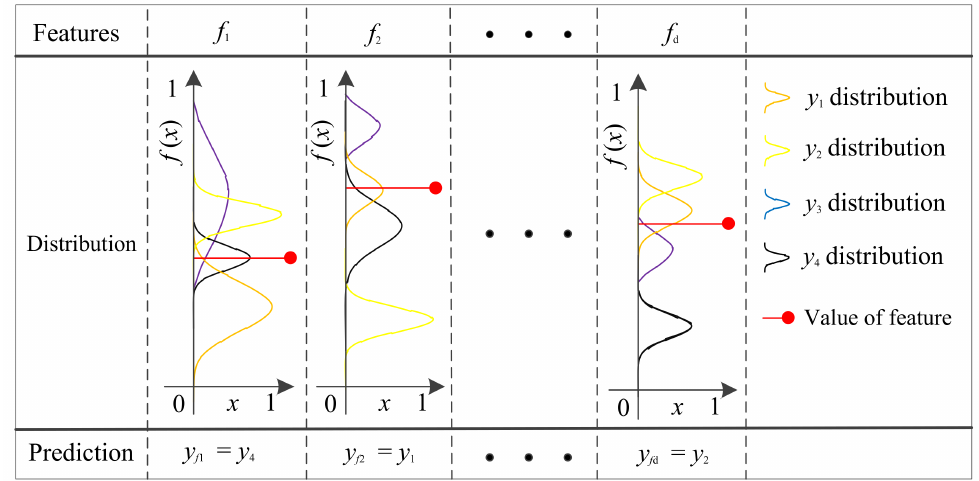
Figure 2. Diagram of feature classification based on Gaussian probability density